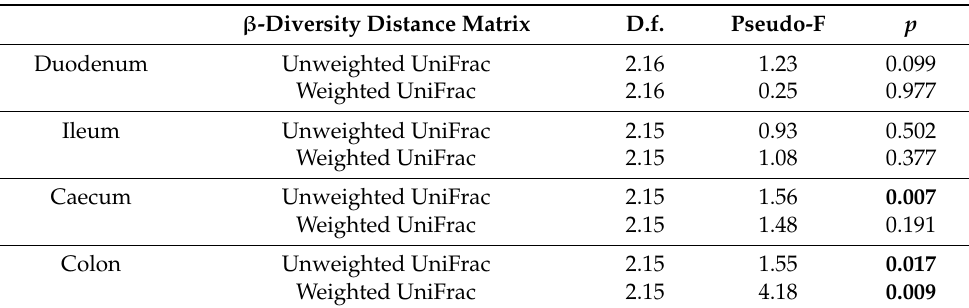
Figure 3. Dimensional figures showing the first two axes of Principal Coordinate Analysis and representing bacterial communities of weaned piglets in all gut regions and taking into account only caecum and colon using Unweighted and Weighted UniFrac distance matrixes. Samples are colored by treatment (Control—yellow; Antibiotic—blue; Allium extract —red) and samples from each intestinal region are represented by different shapes (Duodenum—ring; Ileum—sphere; Caecum—cone; Colon—square). Proportion of explained variance by each PCo axes is shown. Table 3. General Linear Models exploring the effects of treatment in beta diversity indices of bacte- rial community of weaned piglets fed with control diet or supplemented with antibiotic or Allium extract. D.f. refers to degree of freedom. The first number is the degree of freedom of the independent variable and the second one for the error term. Significant p -values are shown in bold.